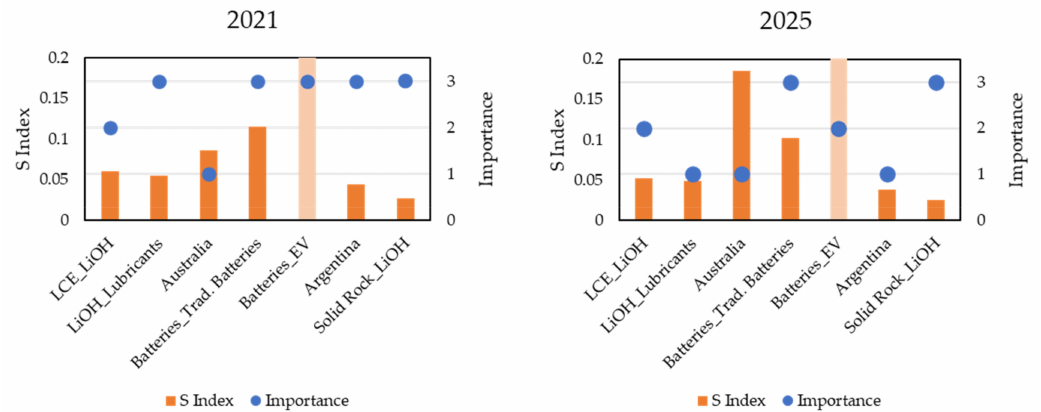
Figure 11. Sensitivity vs. importance in electric vehicle production in 2021 and